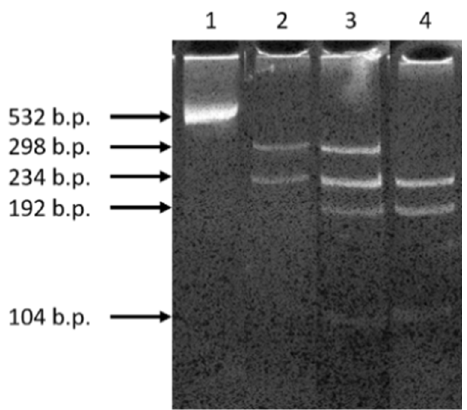
Figure 3. Electrophoregram of PCR-RFLP test-system performance for population screening for